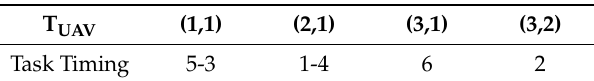
Table 2. Task Assignment